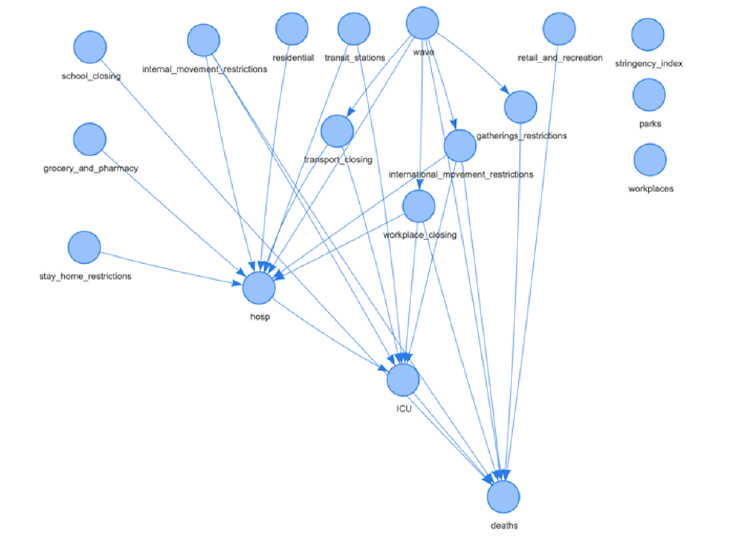
Figure 14. BN structure for Israel. The figure is downloadable from https://tinyurl.com/rbexhtww (accessed on 26 February